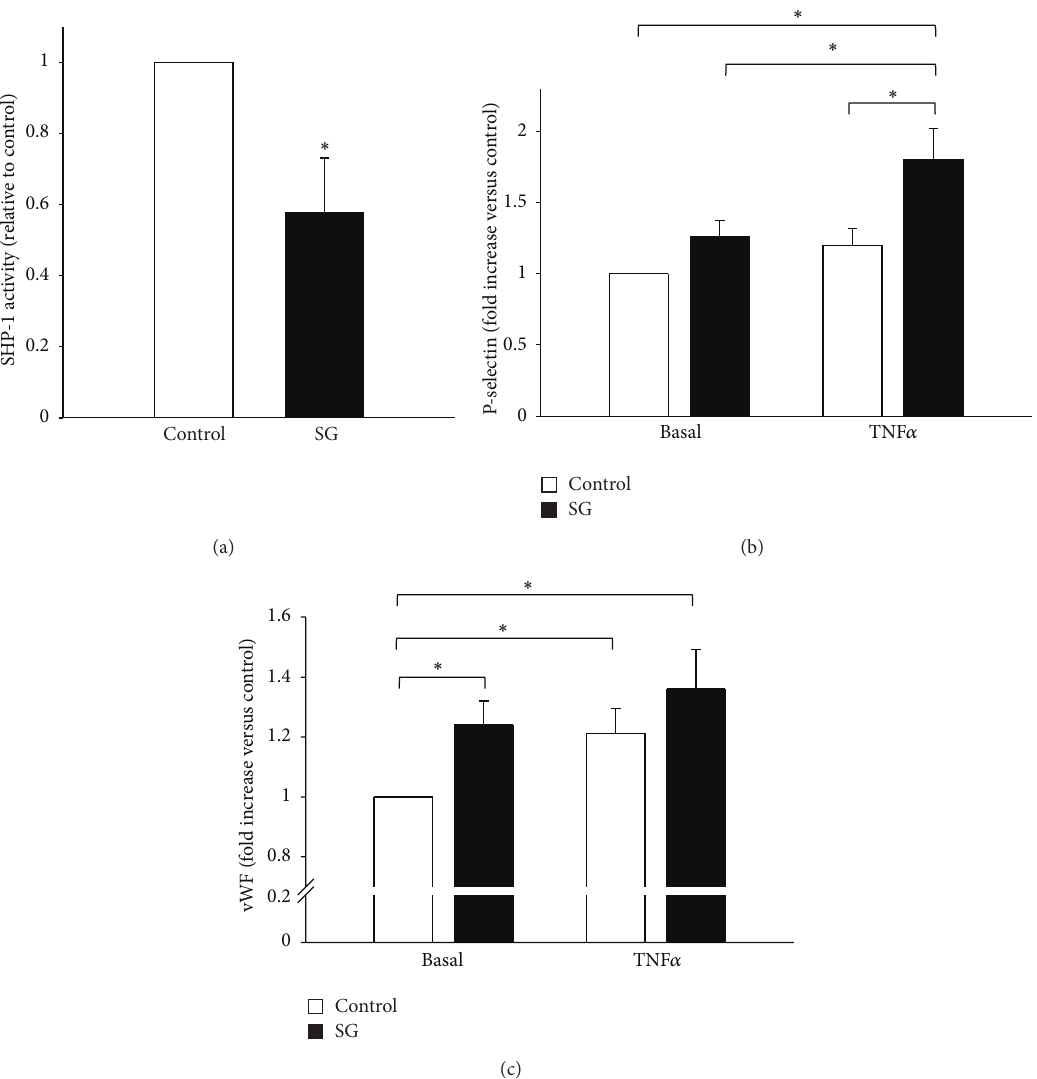
Figure 3: Inhibition of SHP-1 increases TNF 𝛼 -induced upregulation of p-selectin and vWF in endothelial cells in vitro . (a) Incubation of endothelial cells with the pharmacological SHP-1 inhibitor sodium stibogluconate effectively reduces SHP-1 activity as measured by pNPP- dephosphorylation assay. (b) Endothelial p-selectin was not changed by sodium stibogluconate under basal conditions but, significantly upregulated in TNF 𝛼 -induced endothelial inflammation. (c) vWF was already upregulated by sodium stibogluconate under basal conditions to a similar level as observed in TNF 𝛼 -induced endothelial inflammation. SG: sodium stibogluconate. ∗ Significantly different at 𝑃 < 0.05 (HUVEC, 𝑛 = 9 – 12